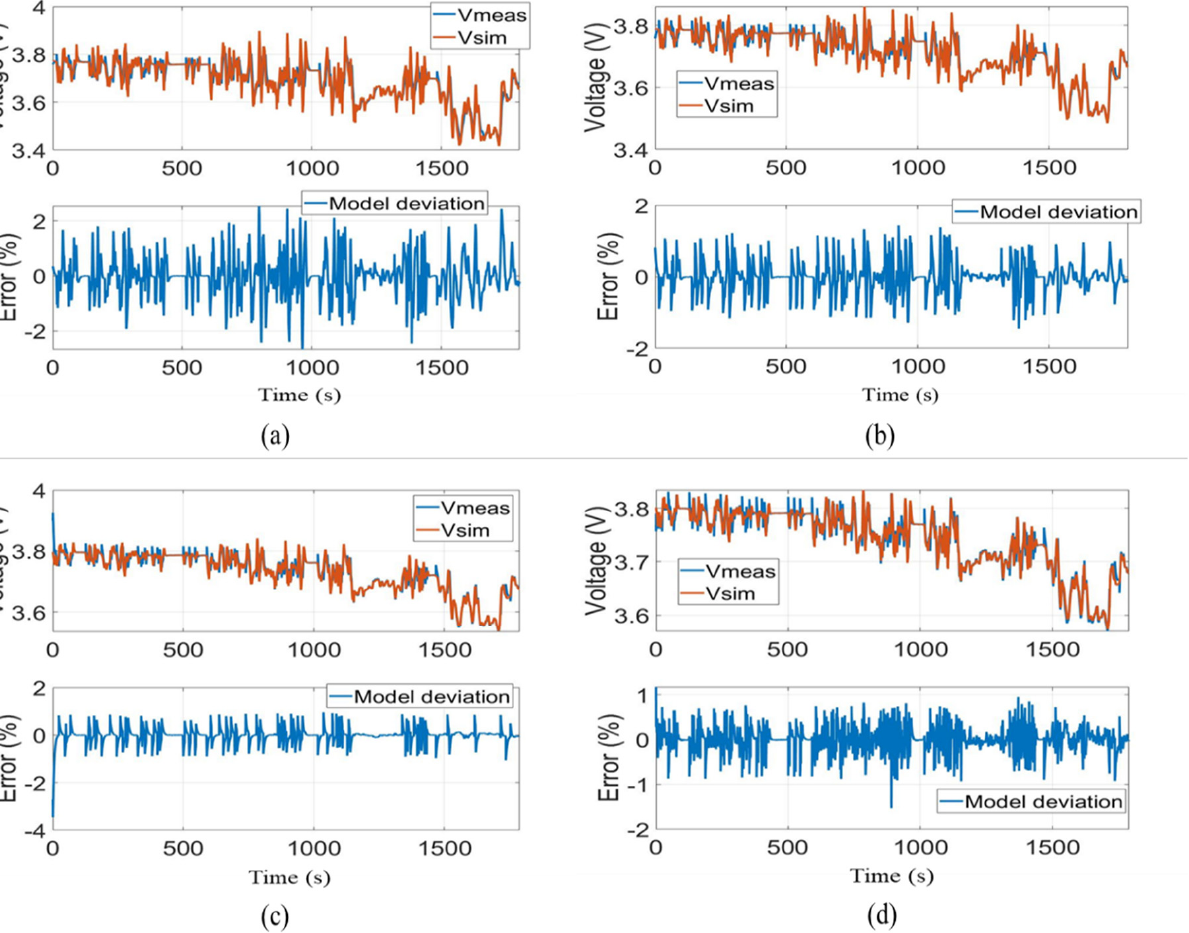
Figure 11. SoC estimation and validation result of the DP_ECM. 4.2. SoP Estimation Results and Model Validation Before the analysis of the SoP of the battery cell, the response of R i as a function of the respective SoC of the cells was illustrated throughout the total FECs. Based on the measured data of the cell, the relation between the SoC, FECs, and R i was presented with a 3D surface fitting curve, shown in Figure 12. Typically, a 100% internal resistance in- crease is considered as the first life EoL of the cell.